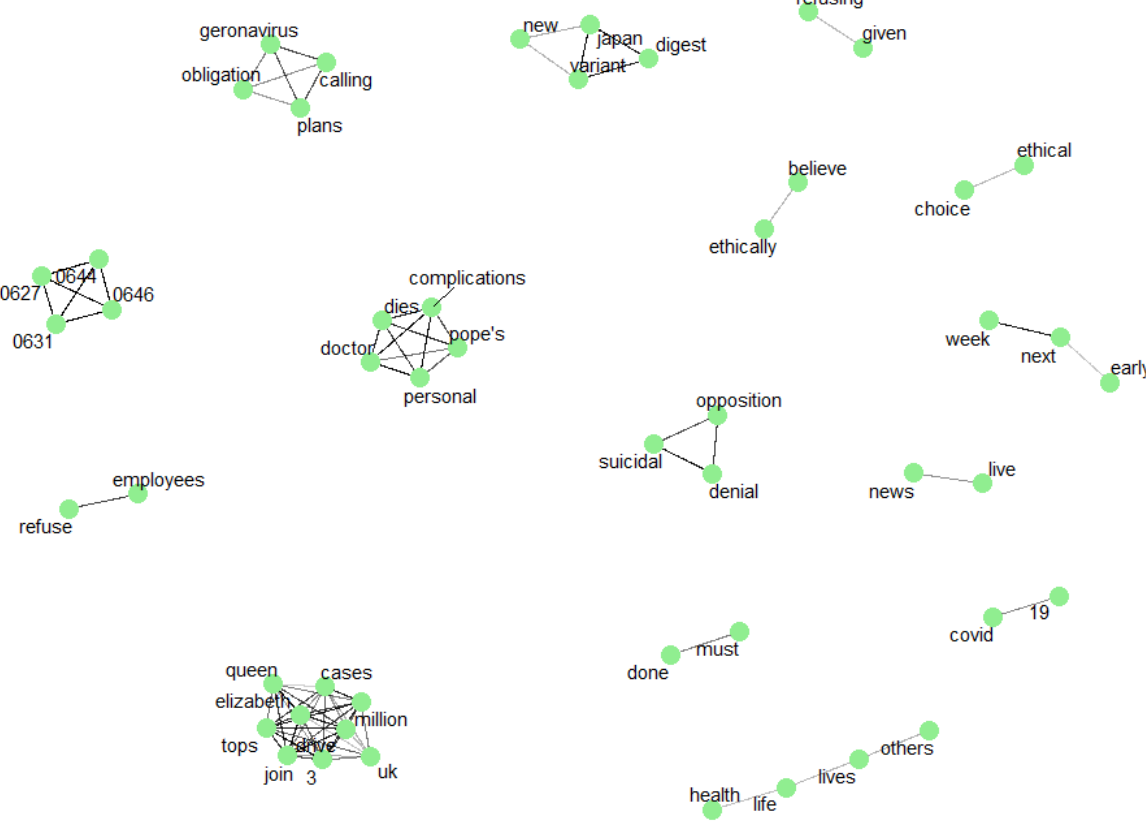
Figure 8. The correlation of words above R > 0.5. Made using ggraph and widyr in